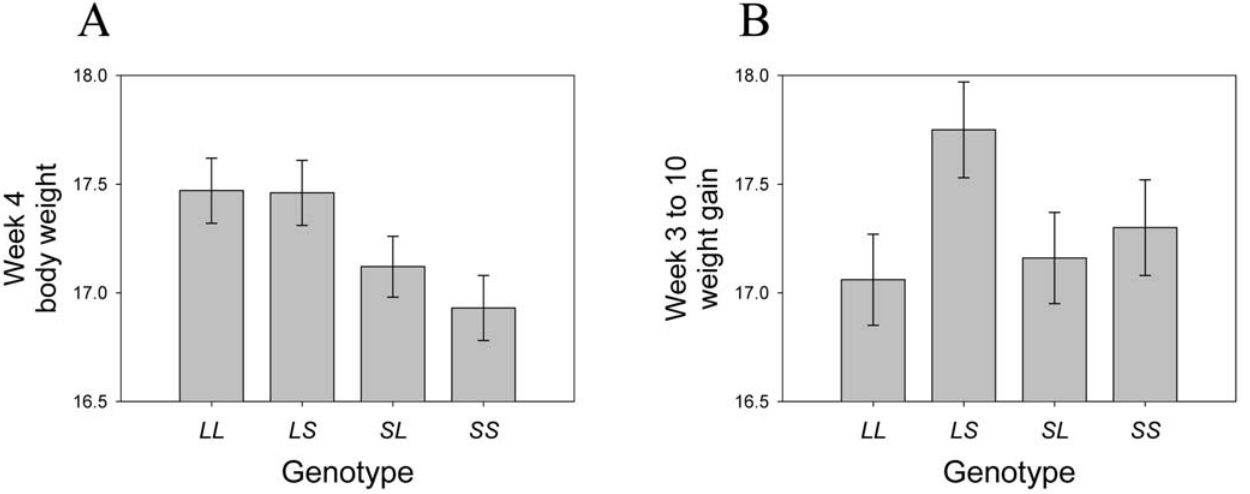
Figure 3. Change in imprinting pattern for i QTL Wti5.1 caused by imprinting effects on growth. For week 4 body weight (g) the locus shows paternal expression (A), but later the locus shows polar overdominance (see Figure 2A for the pattern in week 10). The change in the pattern of imprinting is due to polar overdominance for growth from week 3 to 10 (B), where the LS heterozygote grows more than the other three ordered genotypes. Error bars denote standard errors of the